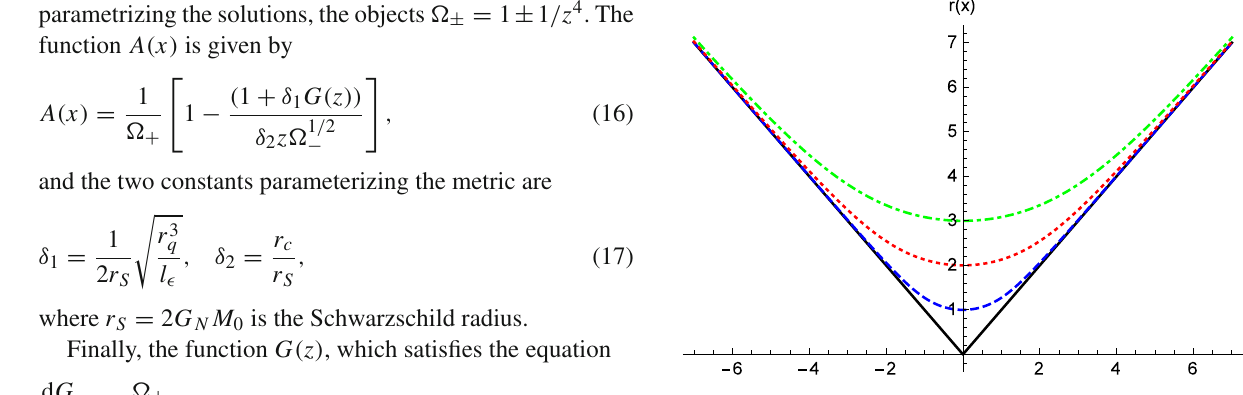
Fig. 1 Representation of the radial function r ( x ) (for r c = 1 , 2 , 3 dashed blue, dotted red and dotted-dashed green, respectively), mea- sured in units of r c . The wormhole throat is located at x = 0, where the area of the 2-spheres reaches a minimum and bounces off to another region of spacetime. Note that a few r c units away from the wormhole throat the radial functions quickly converge to the behavior of the stan- dard Reissner–Nordström solution, r ≈ | x | (straight solid black